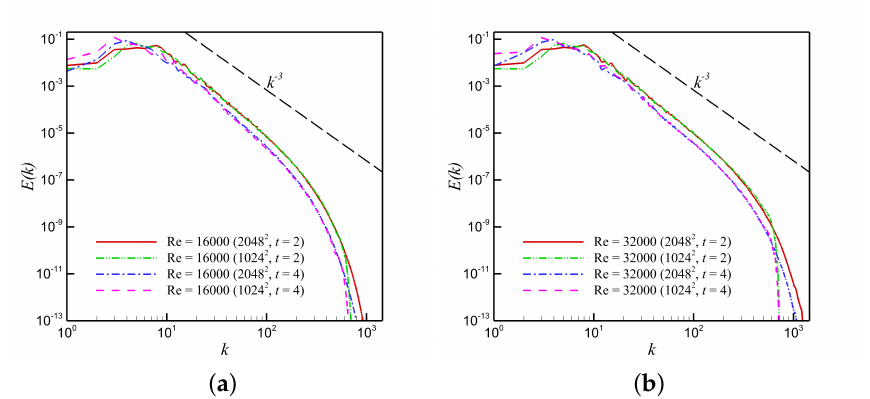
Figure 2. A mesh independence test for Re = 16,000 ( a ) and Re = 32,000 ( b ) using two spatial resolutions. An acceptable match is obtained from both